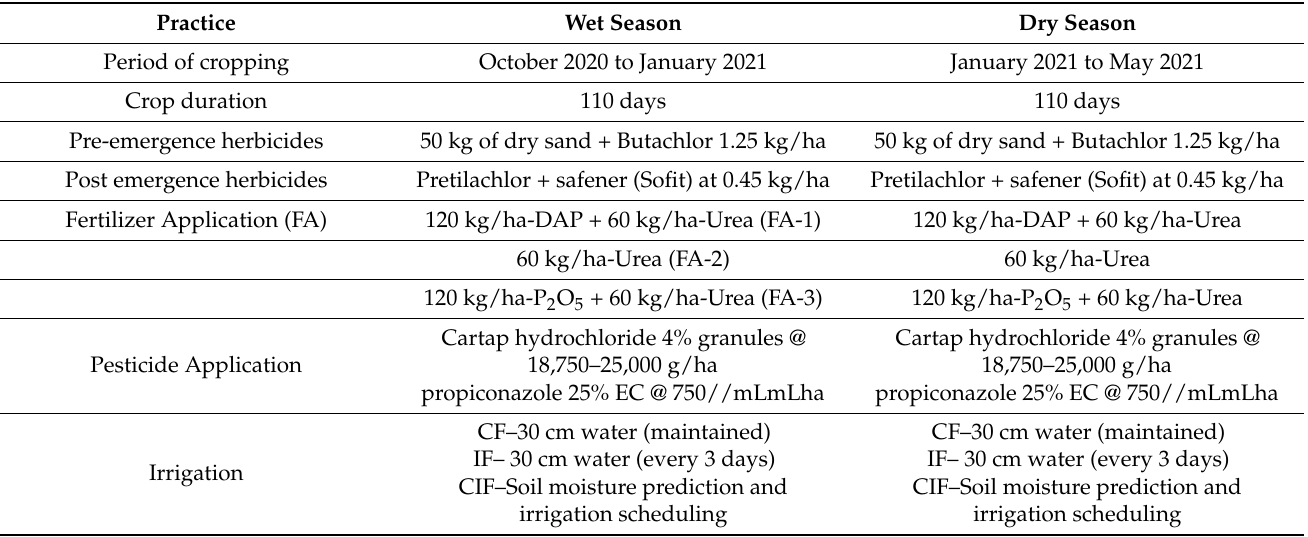
Table 1. Various rice field management practices followed in both